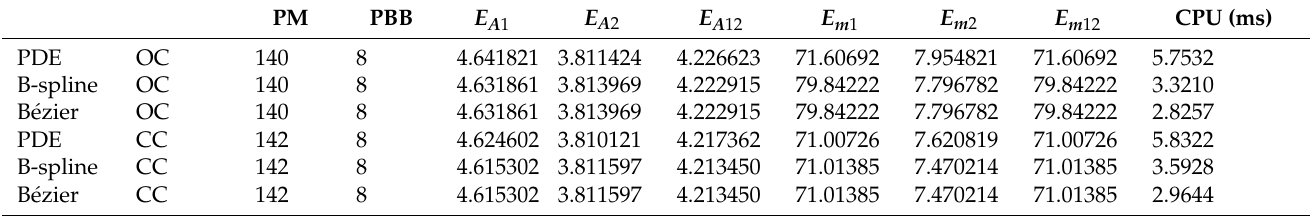
Table 2. Design variables, errors ( × 10 − 3 ), and computational time (CPU) for reconstruction shown in Figure